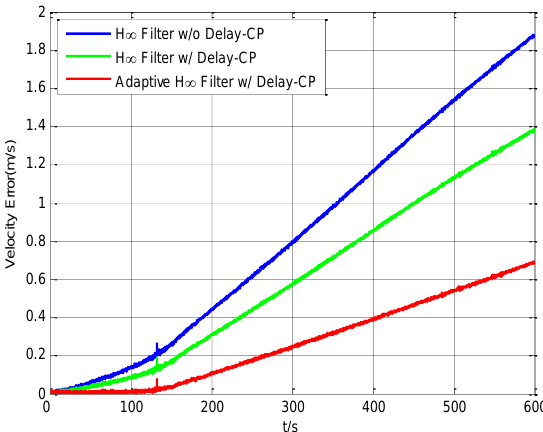
Figure 13. The curves of velocity error in inertial navigation.